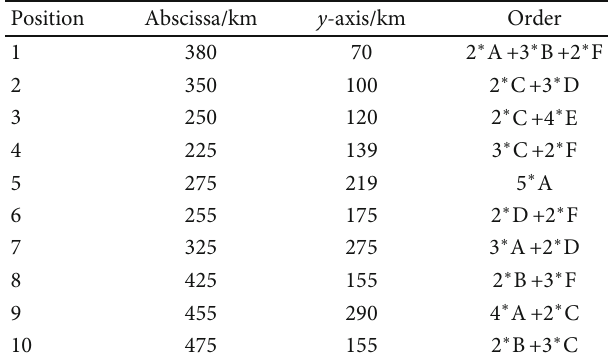
Figure 6: Comparison of optimal distances. Table 2: The location and demand of each customer